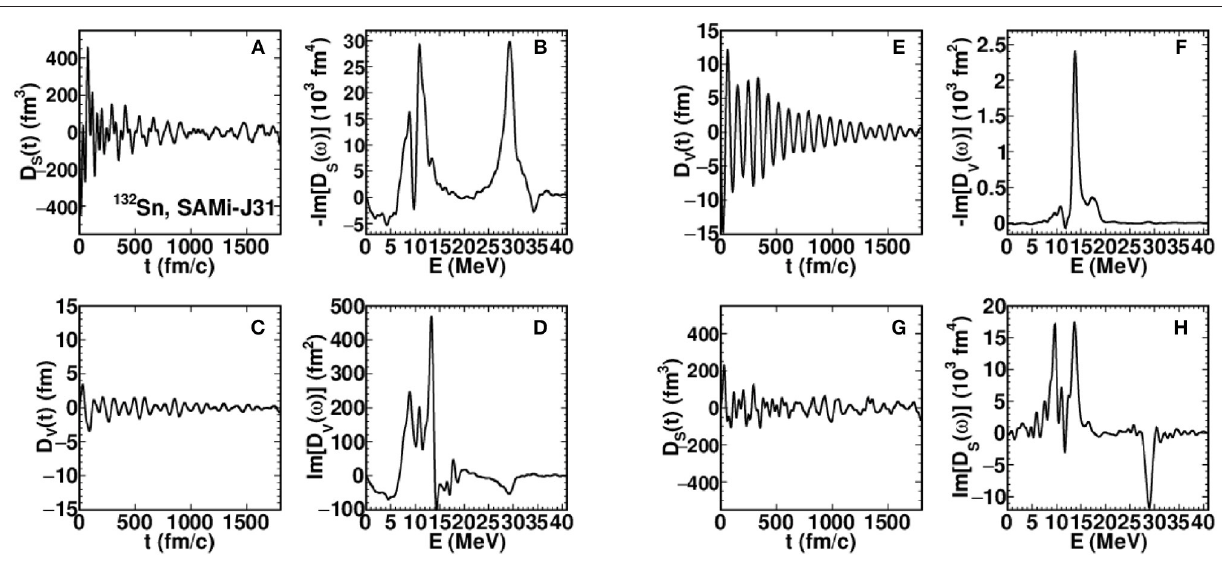
FIGURE 3 | The dipole oscillations and corresponding response functions for 132 Sn and the SAMi-J31 interaction. Panels from (A–D) represent the results obtained with the initial IS perturbation and panels from (E–H) show the results obtained with the initial IV perturbation. Readapted from Zheng et al.